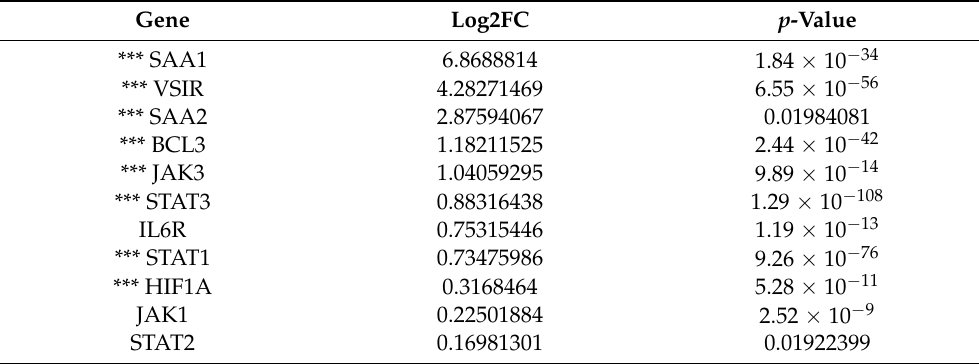
Table 6. Immunomodulators significantly upregulated in MDA MB 468 by human visceral adipocyte- conditioned